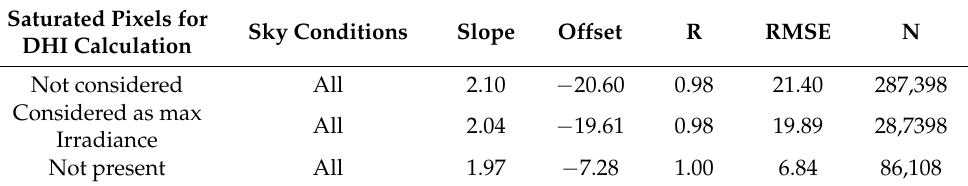
Table 5. Linear fit parameters obtained from the validation of the broadband diffuse irradiance. Saturated Pixels for Sky DHI Calculation